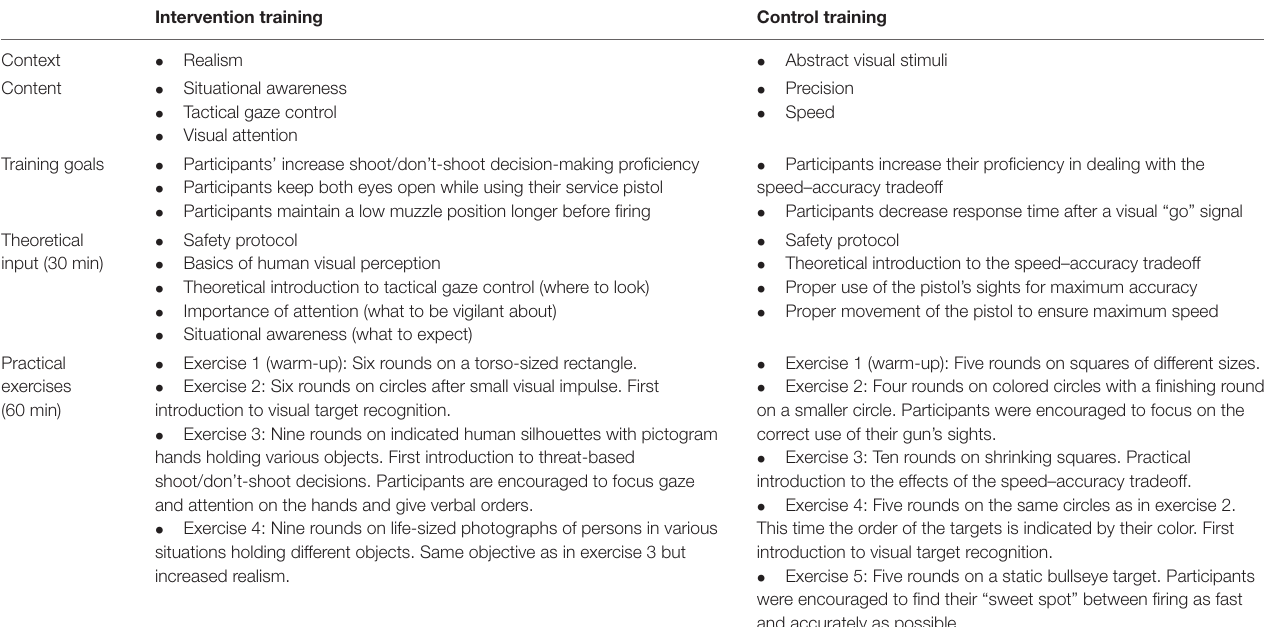
TABLE 2 | Comparison of both training